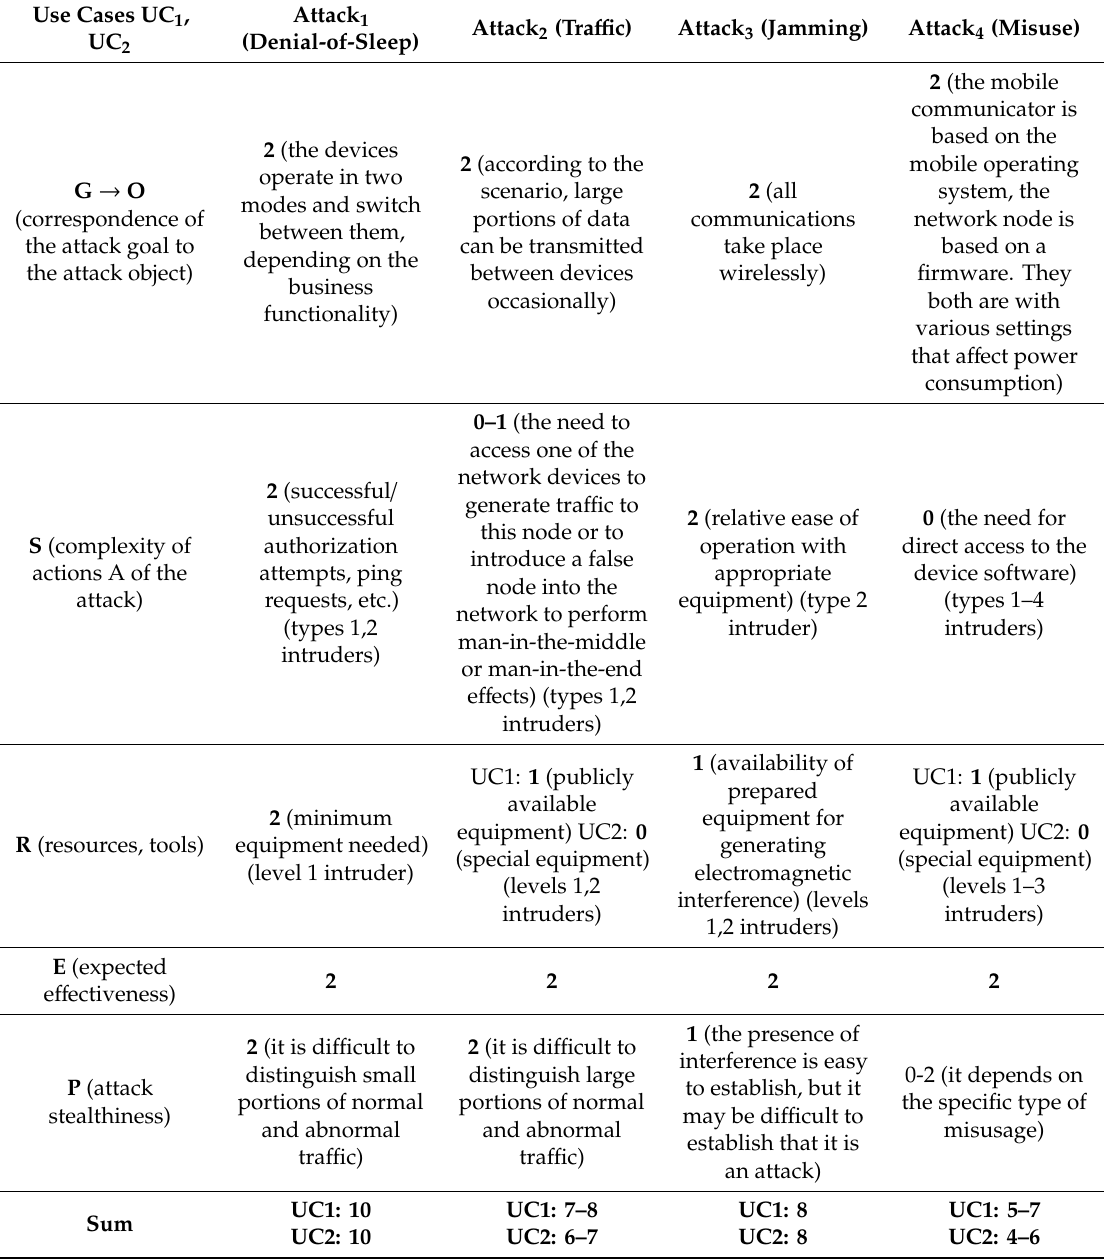
Table 5 exposes the following